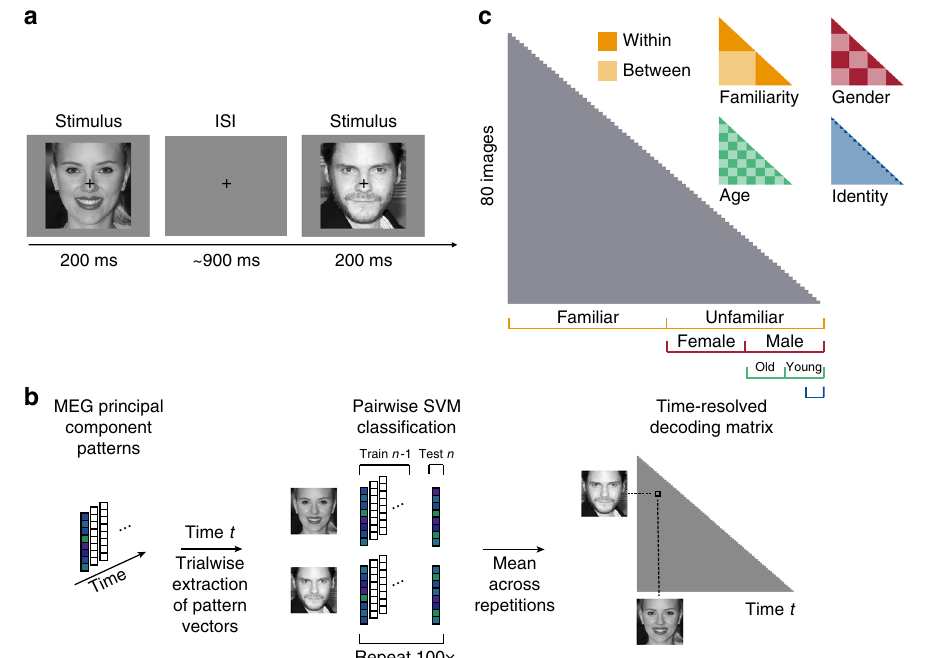
Fig. 1 Task and multivariate MEG analyses. a Subjects viewed 80 images of faces while performing a 1-back task on the image. Each image was presented for 200 ms, followed by a variable [800 – 1000 ms] interstimulus interval (ISI). b MEG analyses were performed in a time-resolved manner on principal components (PCs) extracted from all MEG sensors, separately for each subject (see Methods section). For each time point t , we extracted the pattern of response across PCs for each condition and each trial and performed pairwise cross-validated SVM classi fi cation. The resulting decoding accuracy values resulted in an 80 × 80 representational dissimilarity matrix (RDM) for each time point. c To perform representational similarity analysis (RSA), we constructed model RDMs for each face dimension (1 corresponding to between and 0 corresponding to within category, respectively). Images shown are not examples of the original stimulus set due to copyright; the exact stimulus set is available at [https://osf.io/gk6f5/]. Images shown are in public domain and available at